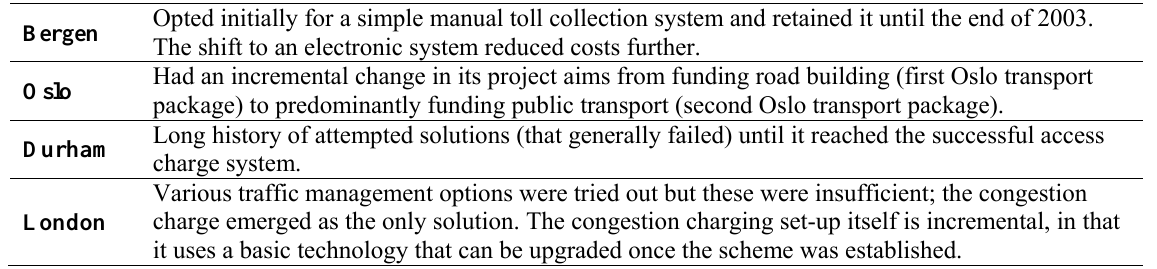
Table 3. Incremental implementation in each of the four cases